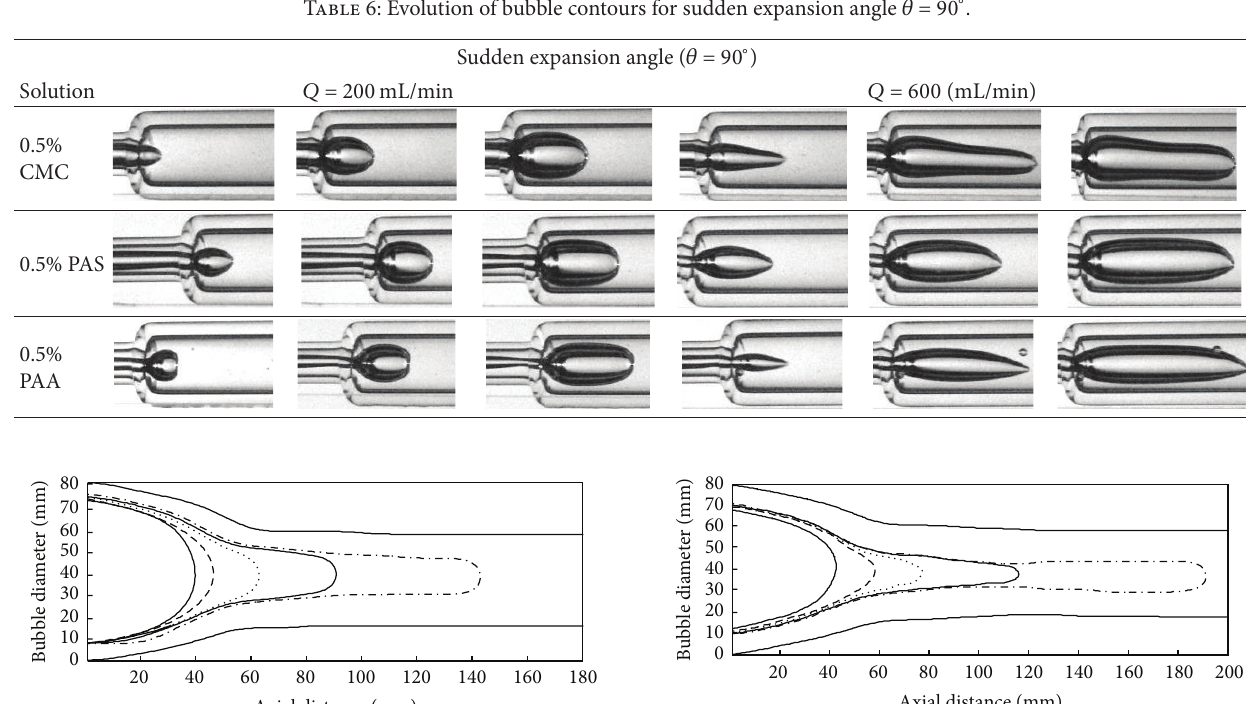
Table 6: Evolution of bubble contours for sudden expansion angle 𝜃 = 90 ∘ .